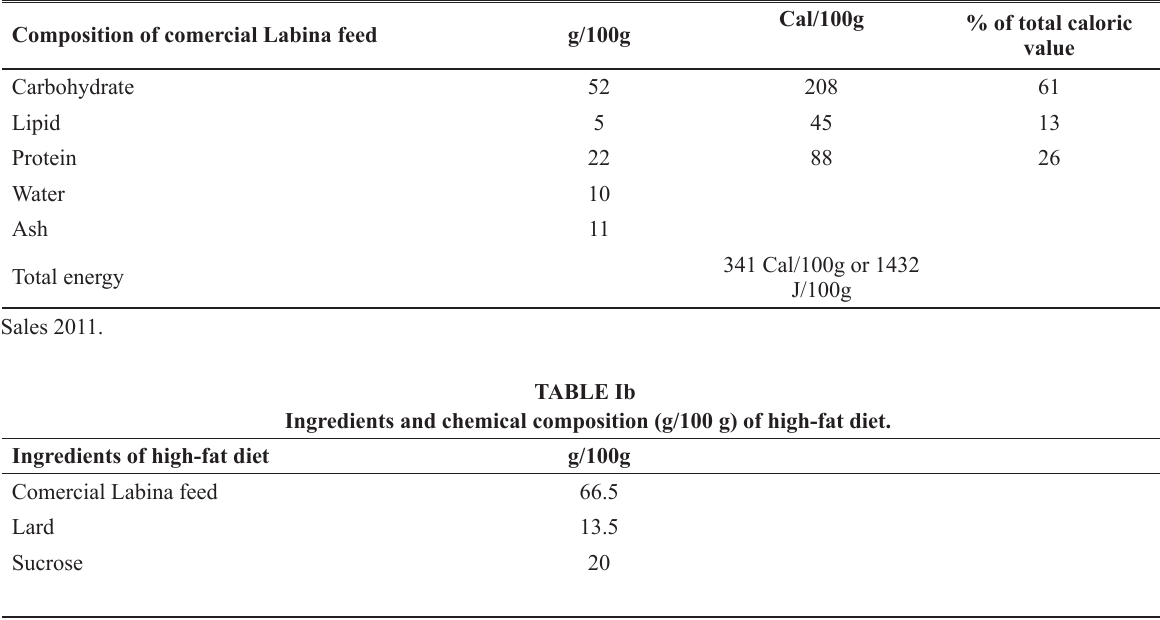
Calories and chemical composition (g/100 g) of Labina feed.